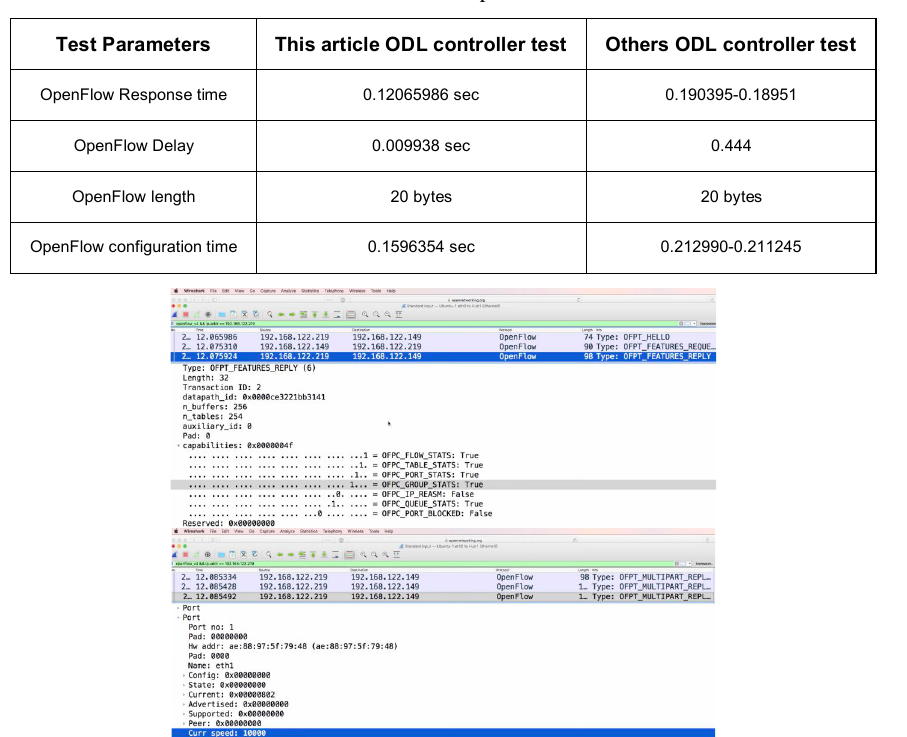
Table 1. ODL test parameters